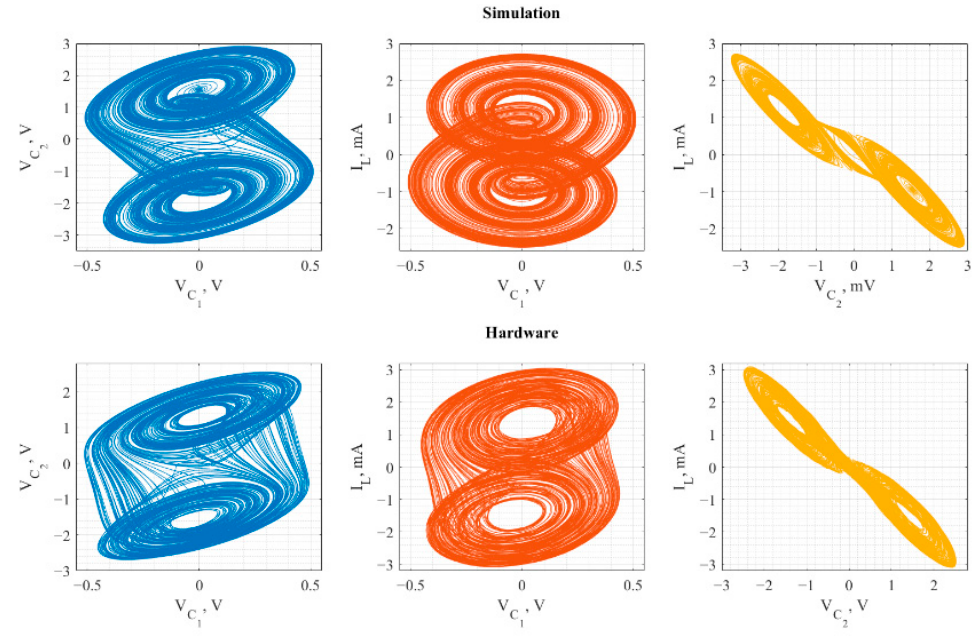
Figure 8. Chua’s chaos oscillator simulation ( top row ) and hardware ( bottom row ) two − dimensional projections.